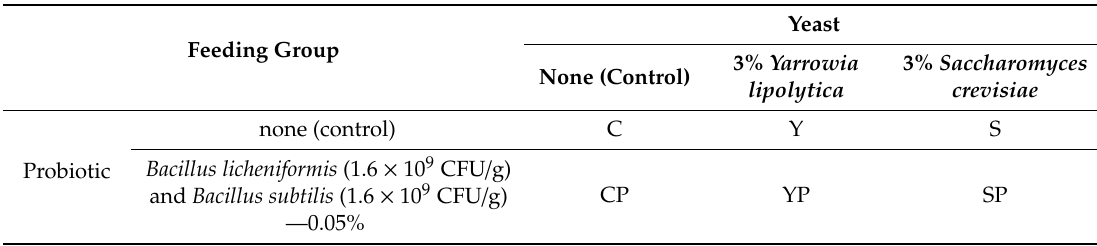
Table 1. Experimental